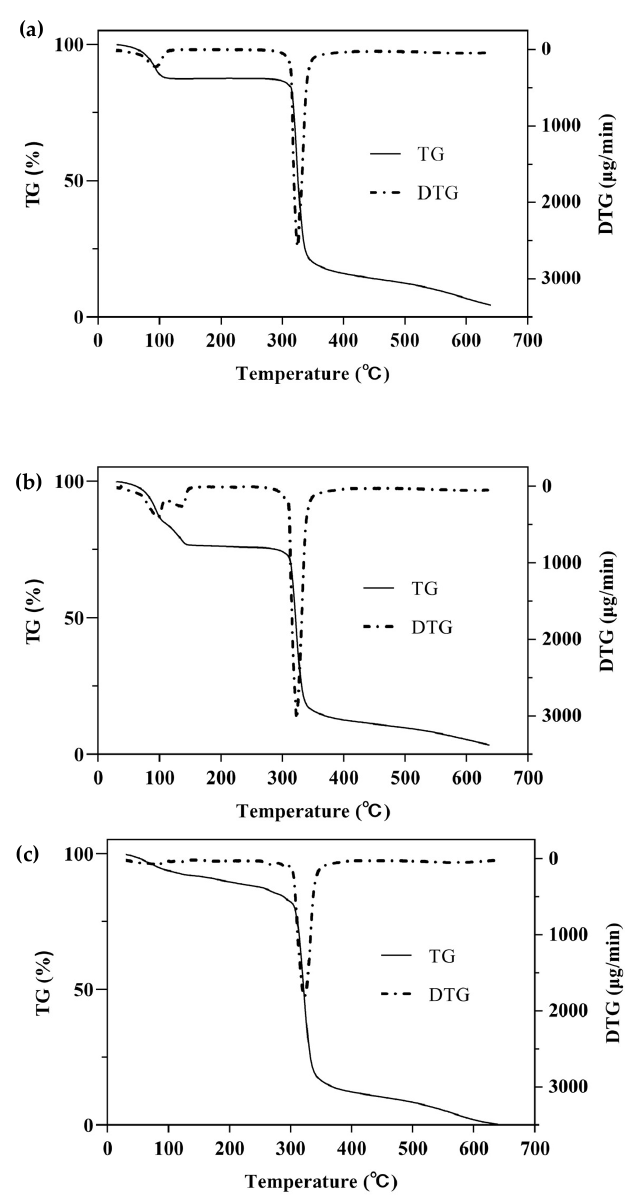
Figure 5. The TGA and DTG curves. ( a ) β-CD; ( b ) PM; ( c ) β-CD/EO IC.